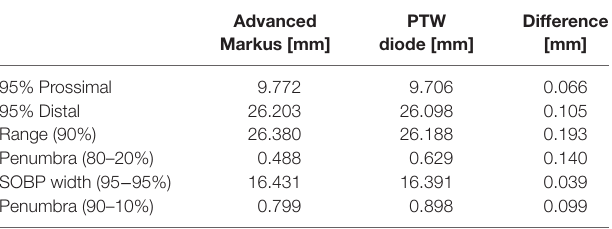
TABle 1 | Comparison of the parameters measured by the PTW diode PR 60020 and the Advanced Markus